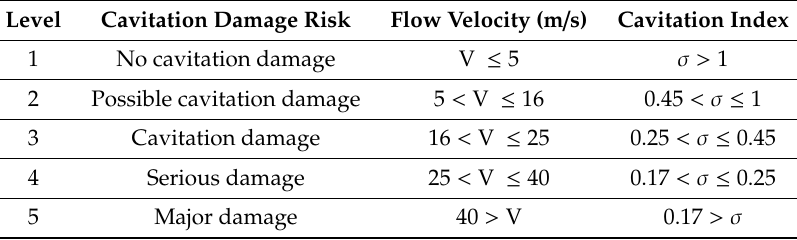
Table 5. Cavitation damage index